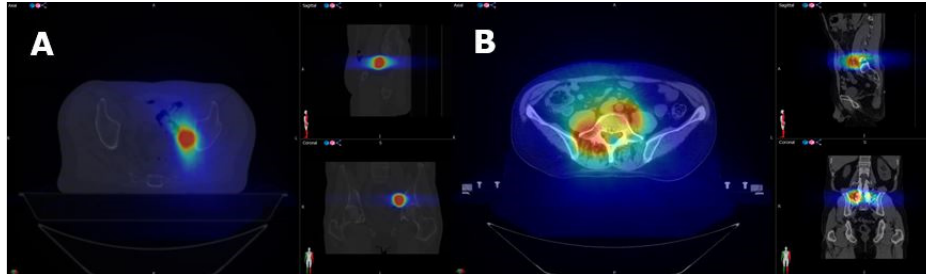
Figure A1. Dose distribution for nodal ( A ) and bone ( B ) SBRT.